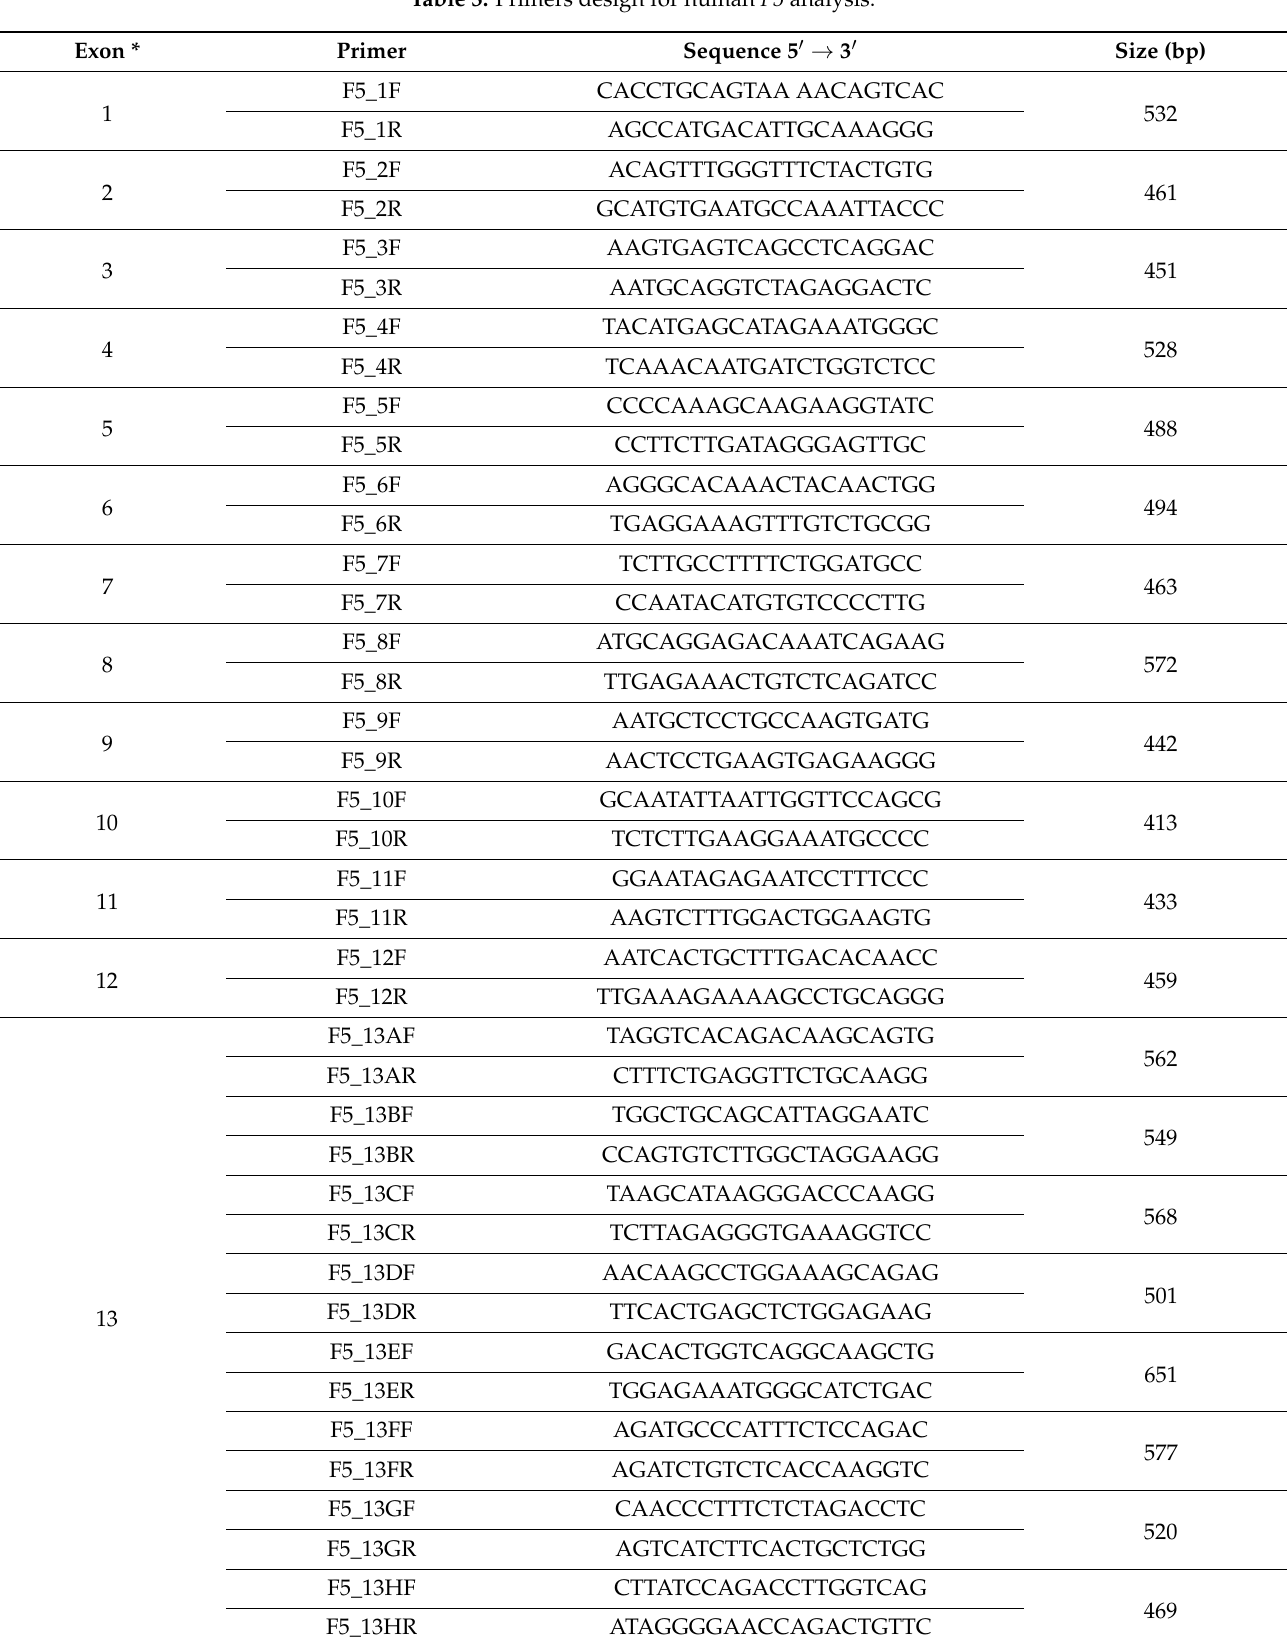
Table 3. Primers design for human F5